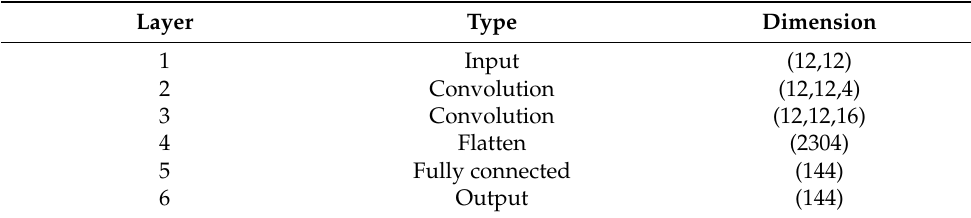
Table 3. The specific parameter settings of the CNN-based prediction model.